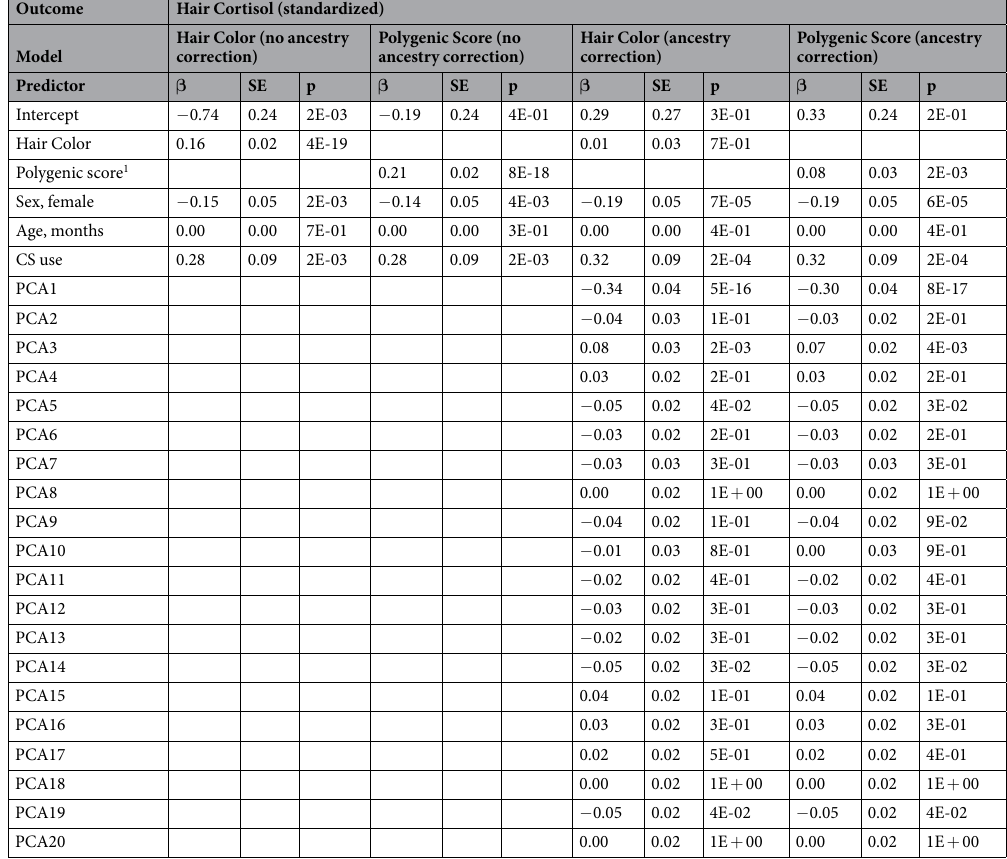
Table 2. Hair cortisol regressed on hair color and polygenic score of hair color in multi-ancestry sample (n = 1674). Positive coefficients indicate increases in hormone concentrations. Higher hair color and polygenic scores indicate darker hair. All models were adjusted for sex, age (in months) and corticosteroid (CS) use. Results are shown for models without and with ancestry correction using 20 prinicipal components as covariates (PCA). 1 Polygenic score is based on 9 SNPs from a training model adjusted for genetic